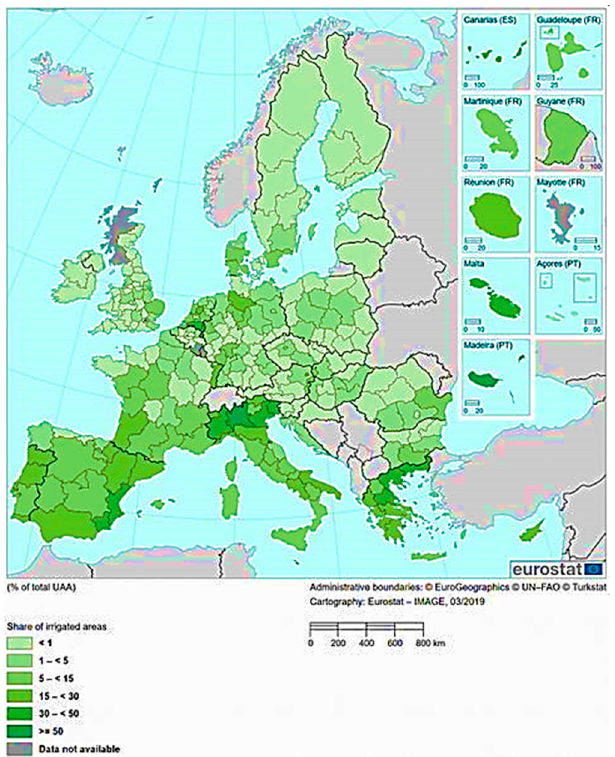
Figure 1. Share of irrigated areas in EU countries in 2016, (Source: Eurostat 2019). The biggest share of irrigable surfaces, at country level, are expectedly found in Southern member states: Greece and Malta share 44.9% and 38.6%, respectively. Cyprus, Italy and Spain followed with 34.9%, 33.9% and 31.1% respectively. An amazingly high figure was the irrigable surface of the Netherlands, 27.0%, and Denmark, 16.8%, countries less linked to the term of irrigation. In Romania and Slovakia, irrigable surface decreased by 11.2% and 4.5% and their share of irrigated areas also decreased by 2.2% and 3.6%, respectively [4,33]. Taking into consideration that the irrigation systems in Romania were built up dur- ing the 1990s, the principal problems now facing the irrigation systems are as follows: low hydraulic efficiency, the high cost of electricity for the systems still based on pumping (the Danube being the main source of water) and high water tariffs. The irrigated area accounts for roughly 22% of the total agricultural surface of the country and roughly 34% of the arable area. It is therefore estimated that approximately 11% of the Romanian agricultural surface is covered by economically viable or marginally viable irrigation networks. Dif- ferences occur from one region to another depending on rainfall and irrigation require- ments. West, Northwest and Center areas possess less irrigation water, while the Southern and Southeast, areas with water problems, enjoy a greater coverage of irrigation systems, [34]. In Romania, the situation of the current irrigation systems infrastructure is character- ized by a low efficiency of base and pumping stations, roughly 45%, and a degree of deg- radation of waterproofing of canals and hydrotechnical constructions of about 75%. In this sense, Romania, through the National Program for Rehabilitation of the Main Irrigation Infrastructure from 2016, will try to outline the strategic goals required regarding the re- habilitation of the main irrigation infrastructure, leading to an increase in the functional area of the viable surface and an increased economically viable margin for irrigation from 70% in 2020 to 90% in 2030 [35]. The specific objective of the program is to increase the efficiency of base (fixed and floating) and pumping stations, eliminating water losses through infiltration from irrigation channels belonging to the public domain and reducing